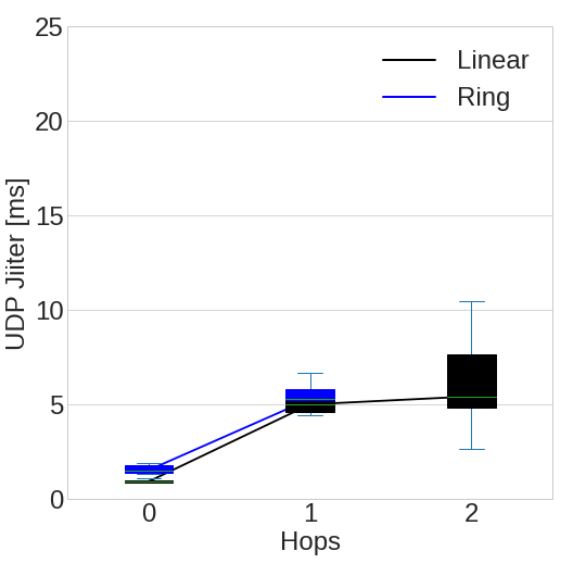
Figure 16. POWDER lab UDP